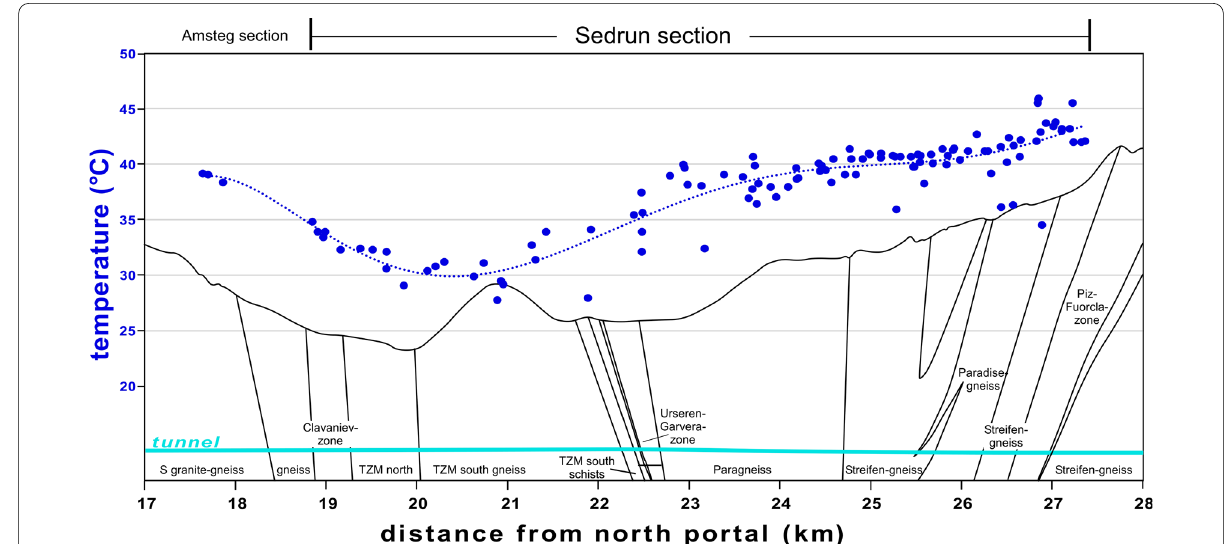
Fig. 3 Water temperature measured in the tunnel. Dotted line: Model temperature fitted to measured